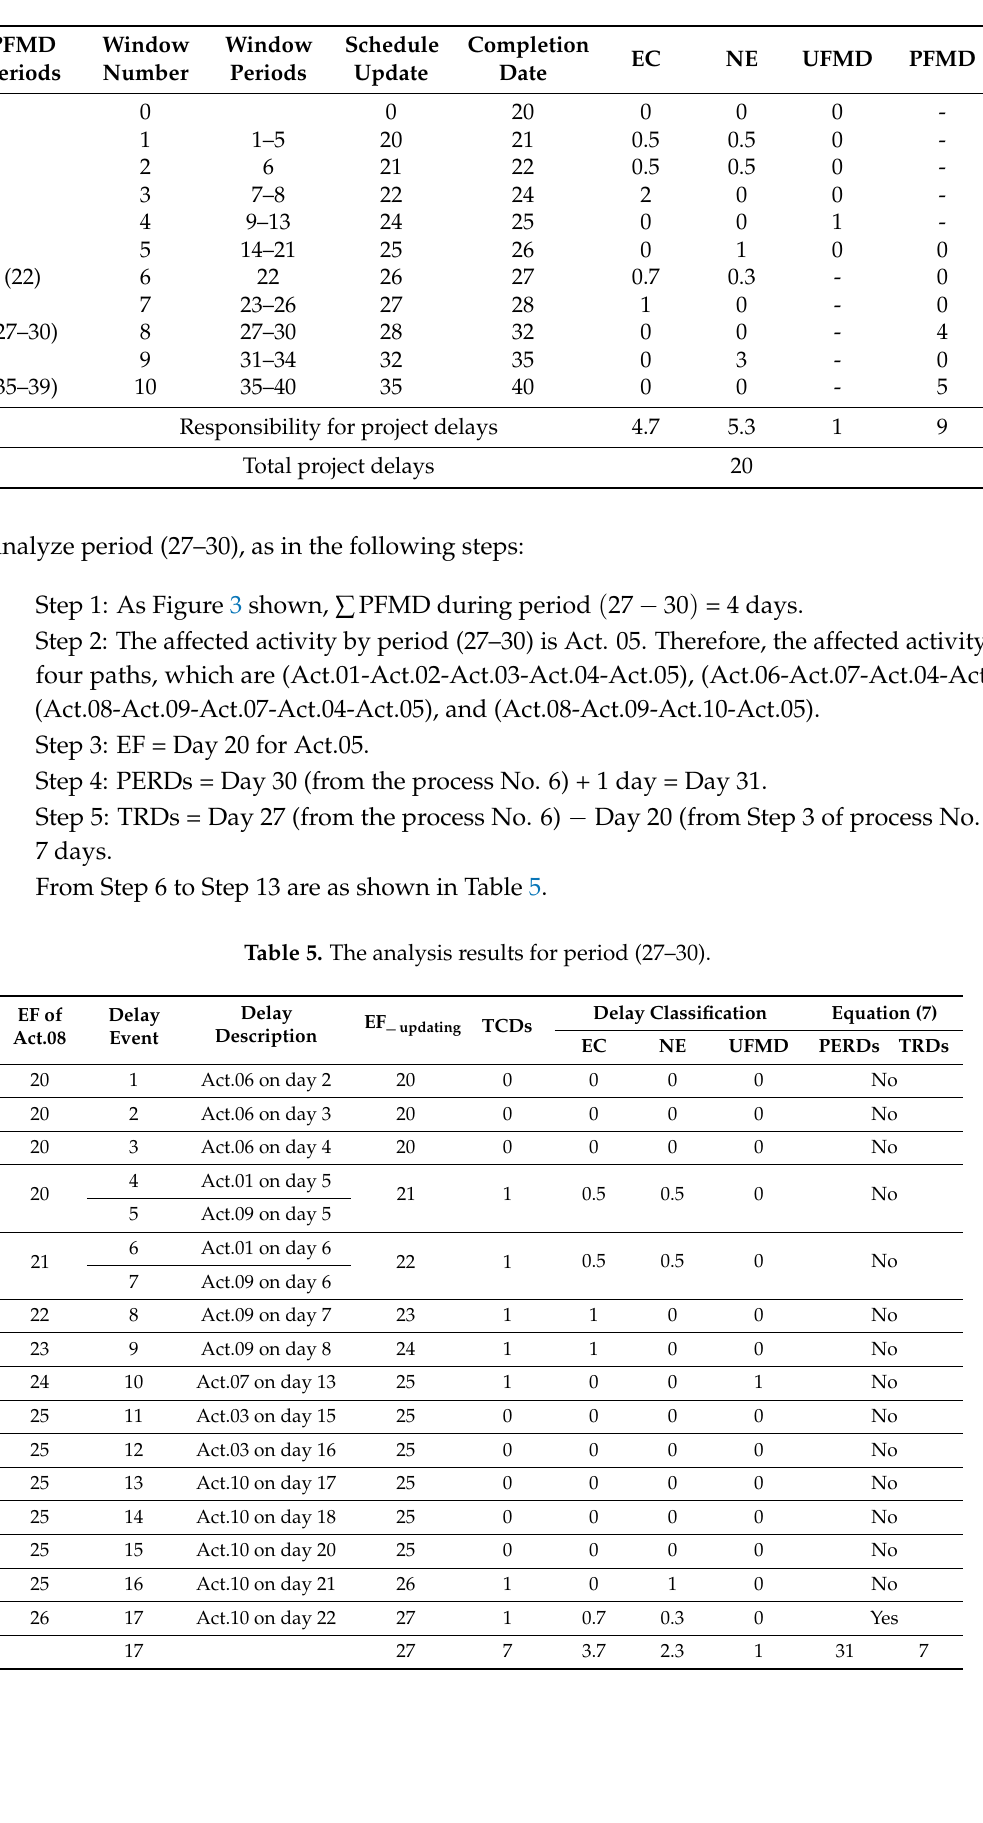
Table 4. The results of period (22) into the project delays.